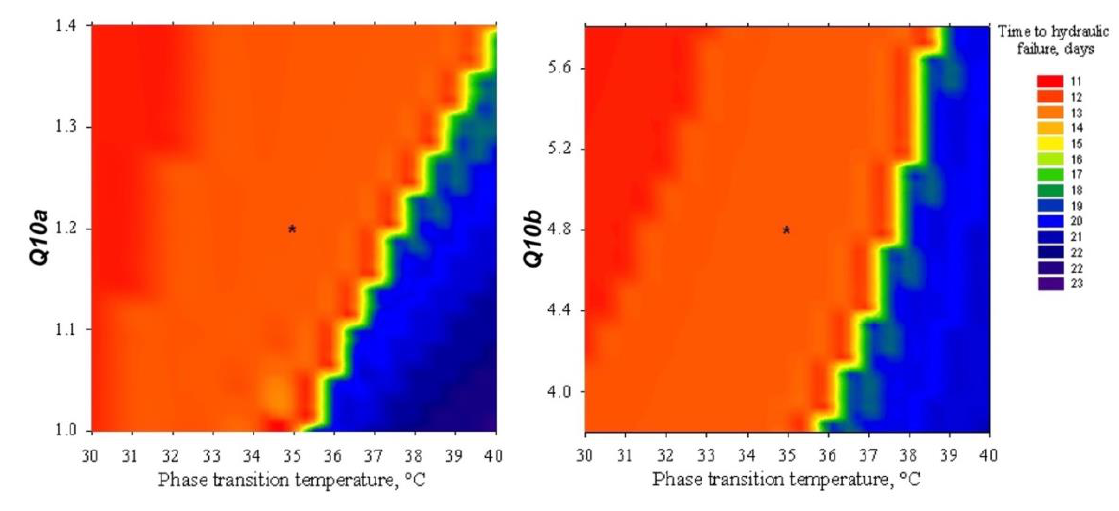
Figure 6. Effects of the phase transition temperature (Tp) and the Q10 of gmin below (Q10a) and above (Q10b) Tp on the time to plant hydraulic failure tHP. tHP is shown as a color spectrum. The